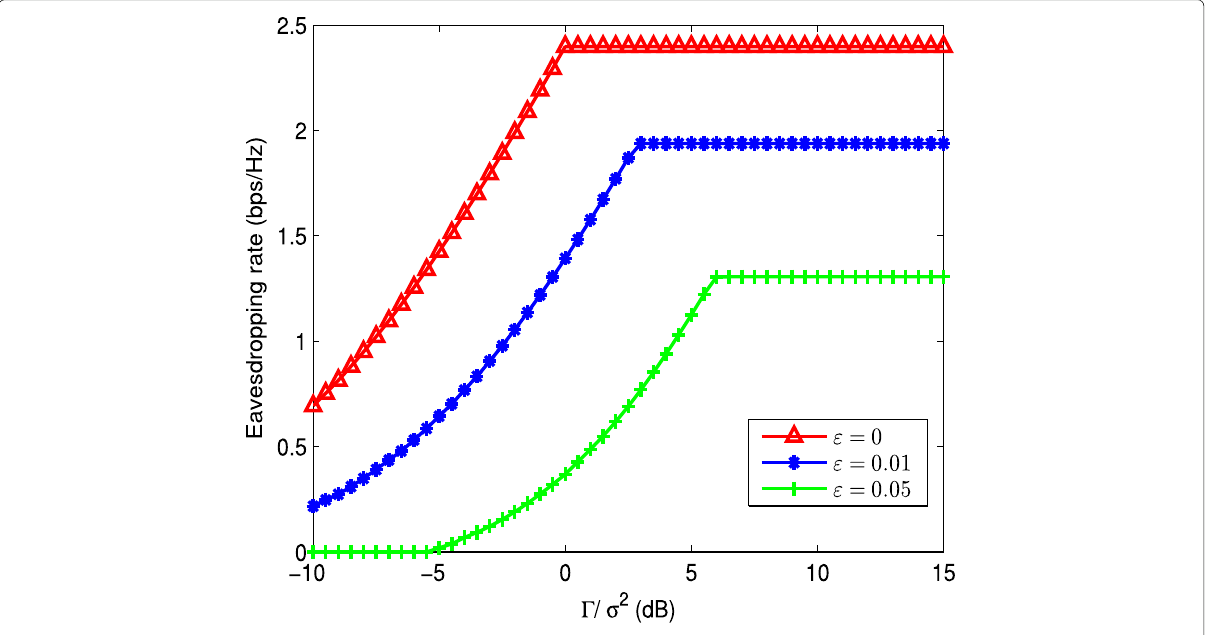
Fig. 3 Eavesdropping rate versus the interference temperature limit at